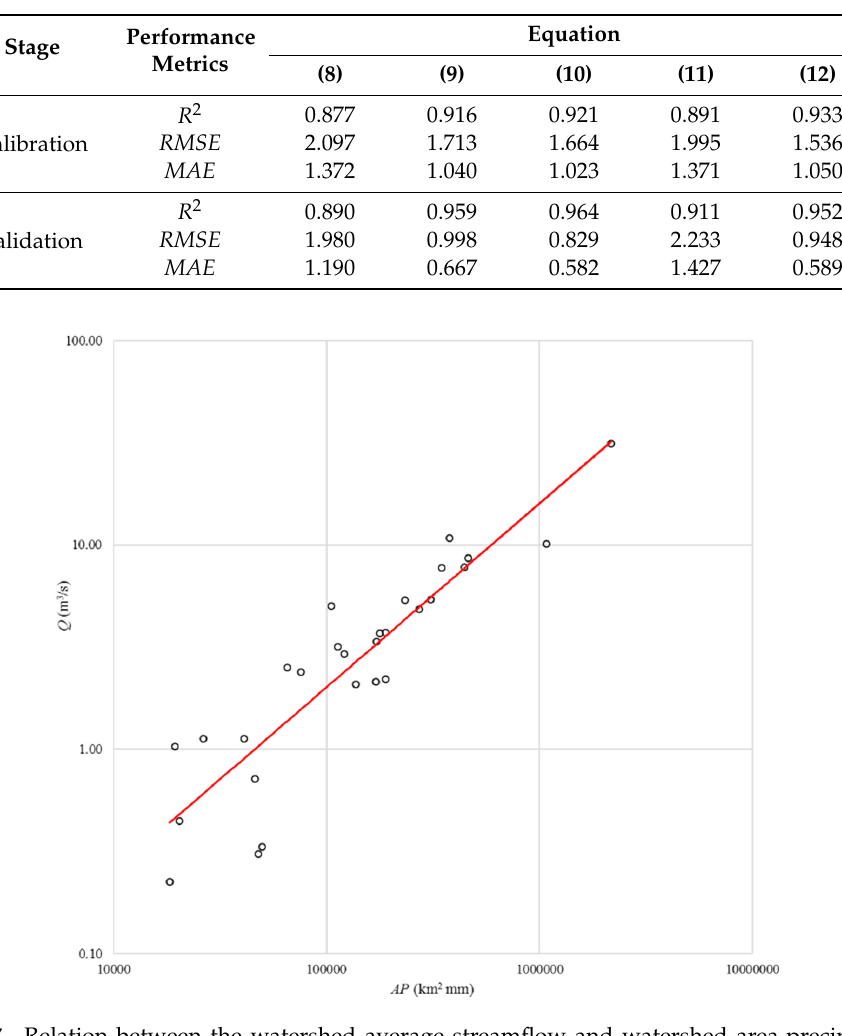
Figure 7. Relation between the watershed average streamflow and watershed area-precipitation (Equation (10)).